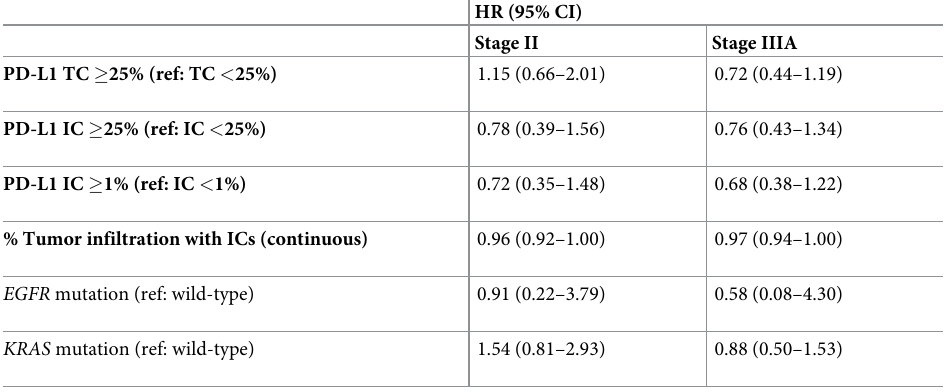
Table 2. Adjusted HR for OS by biomarker status in patients with stage II or stage IIIA NSCLC receiving adjuvant chemotherapy.